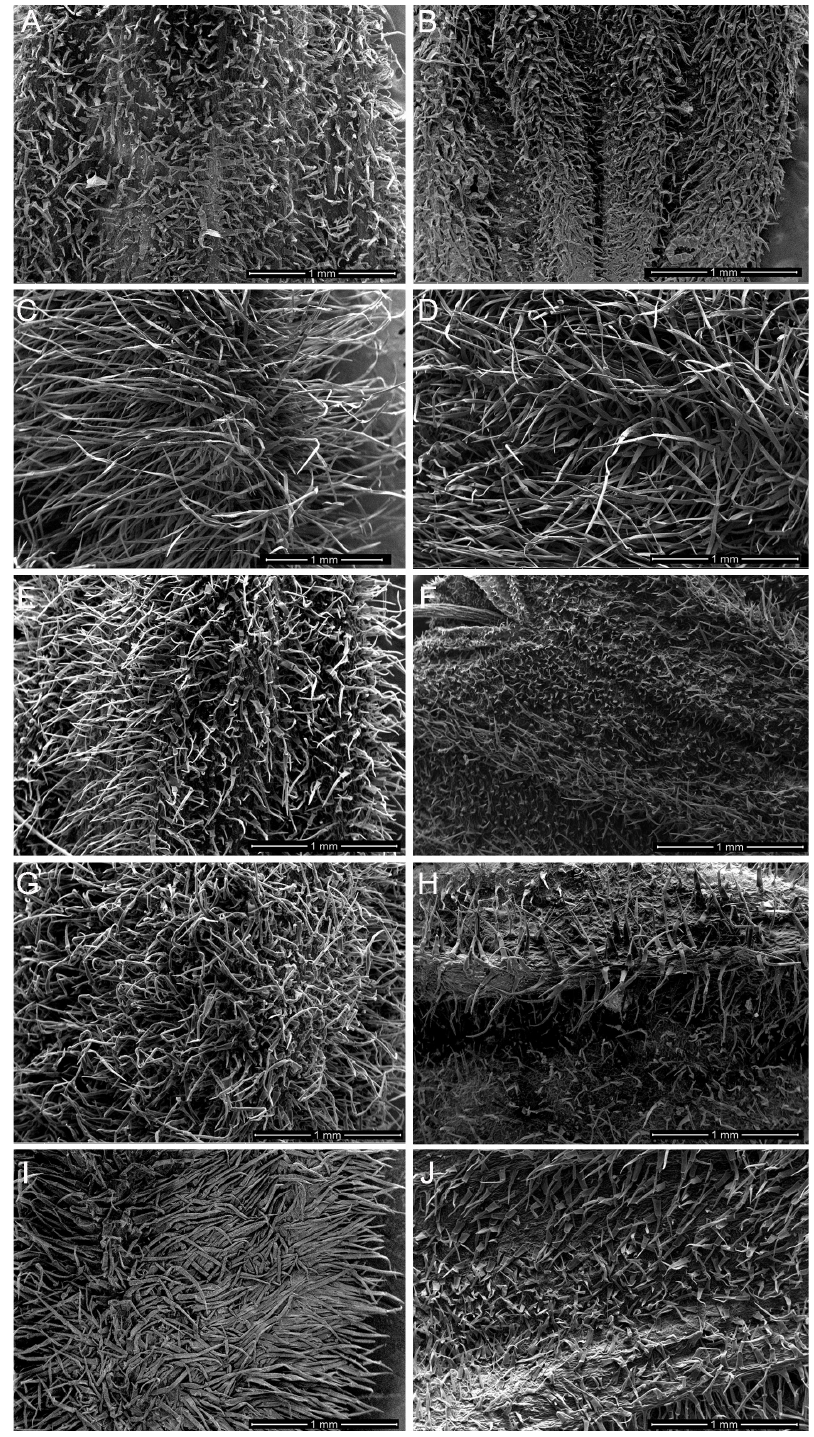
Fig. 8. Comparison between the pubescence of the calyx of the species (photos taken under electron microscope). A, C, G, E, I . The most basal part. B, D, F, H, J . The most apical part. A–B . Stachytarpheta brevibracteata (Moldenke) P.H.Cardoso ( P.H. Cardoso & W.P. Leite 66 ). C–D . S. longipedicellata (Moldenke) P.H.Cardoso ( P.H. Cardoso et al. 59 ). E–F . S. longispicata (Pohl) S.Atkins ( P.H. Cardoso et al. 48 ). G–H . S. minasensis (S.Atkins) P.H.Cardoso ( F.R.G. Salimena & P.H. Nobre 459 ). I–J . S. ratteri (S.Atkins) P.H.Cardoso ( P.H. Cardoso et al. 51